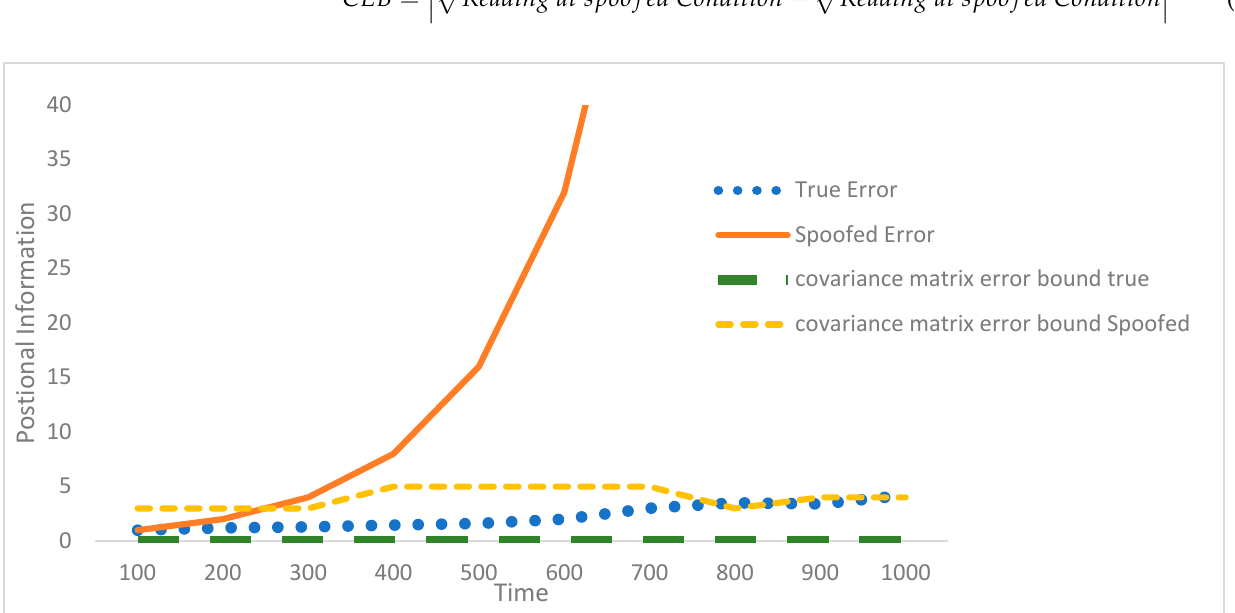
Monte Carlo simulation in the probability model was used to launch the spoofing attack. During the navigation, deviation from the actual route can be either due to spoofing or environmental and device errors. The covariance matrix was used to identify deviation from the actual route due to the presence of a spoofing attack. Figures 11 and 12 show the use of the Error covariance matrix to identify the true positional errors under normal conditions, and errors in position due to spoofing attacks. Equation (21) provides the Error Bound of the covariance matrix ( CEB ).